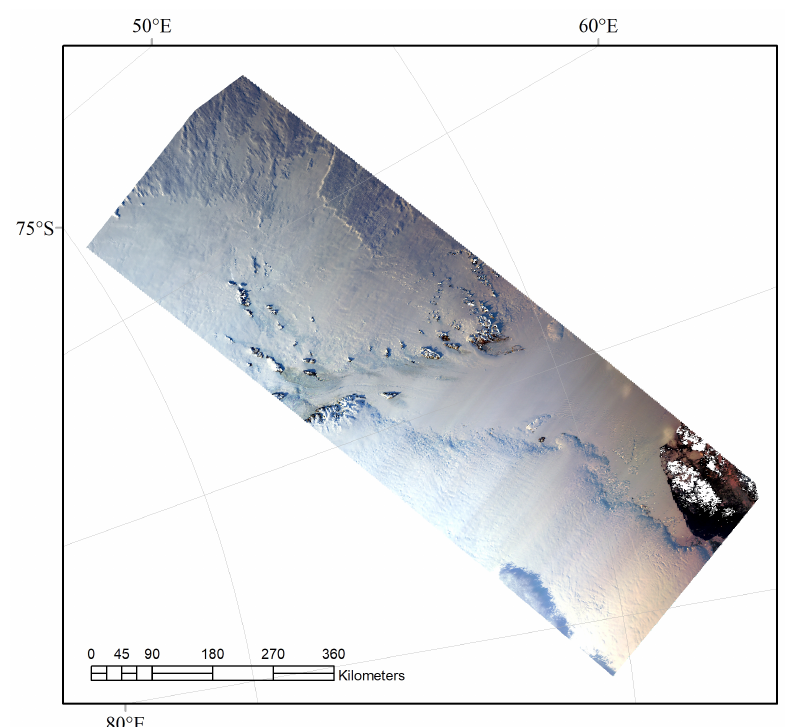
Figure 1. Example of an original HY-1C image of Antarctica. There is uneven lighting in the image.